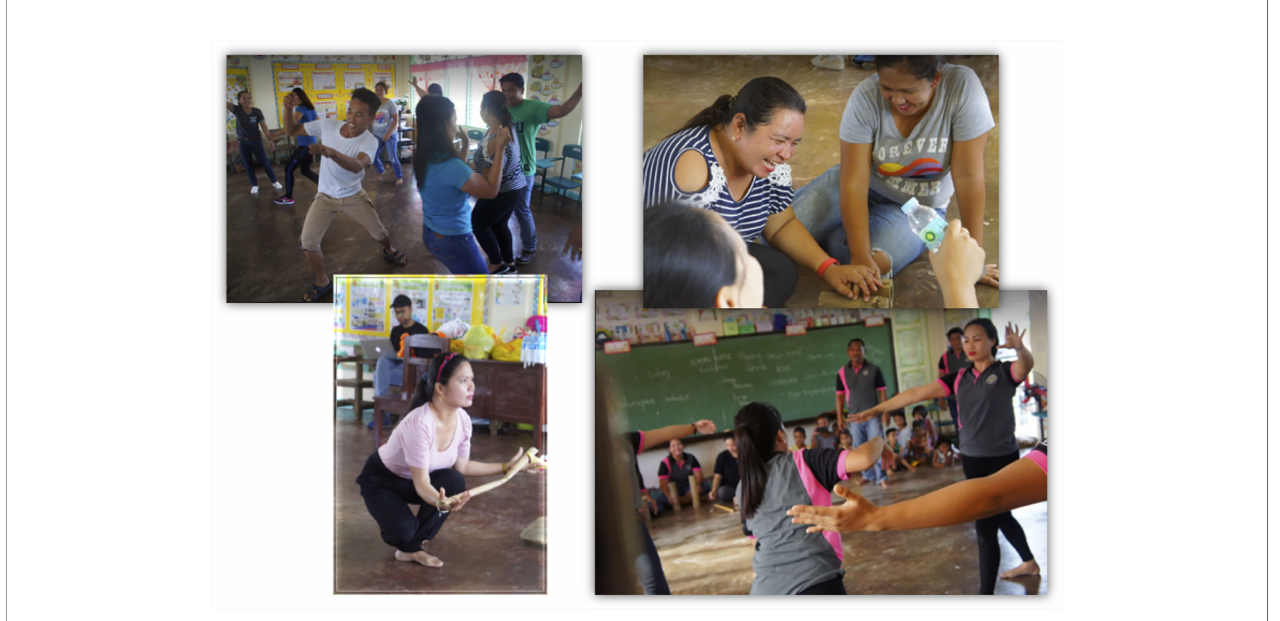
FIGURE 5 | Photos of a community-based theater session (Photos by Dennis Gupa,